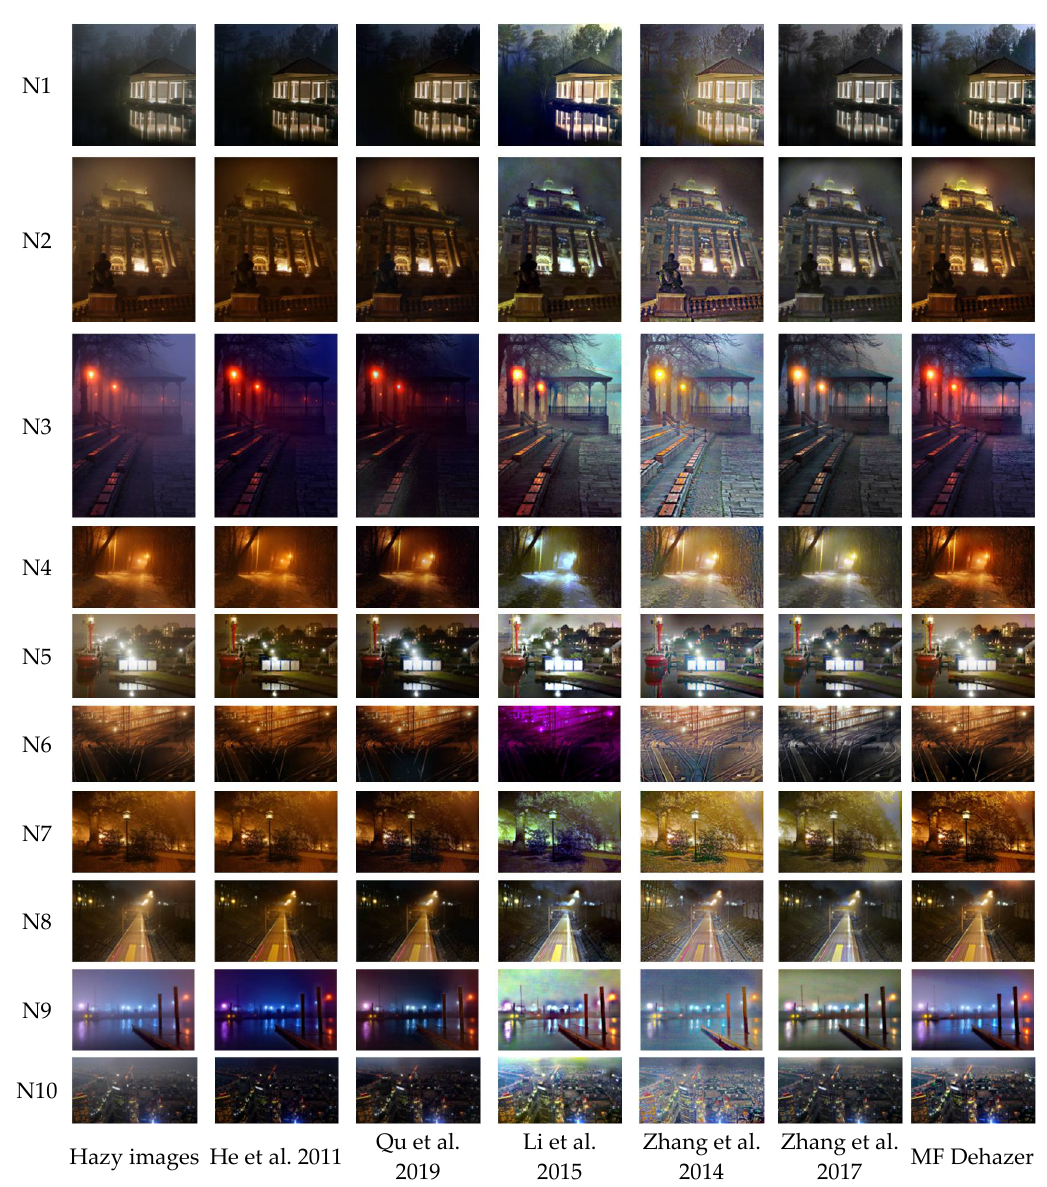
Figure 5. Comparison of nighttime